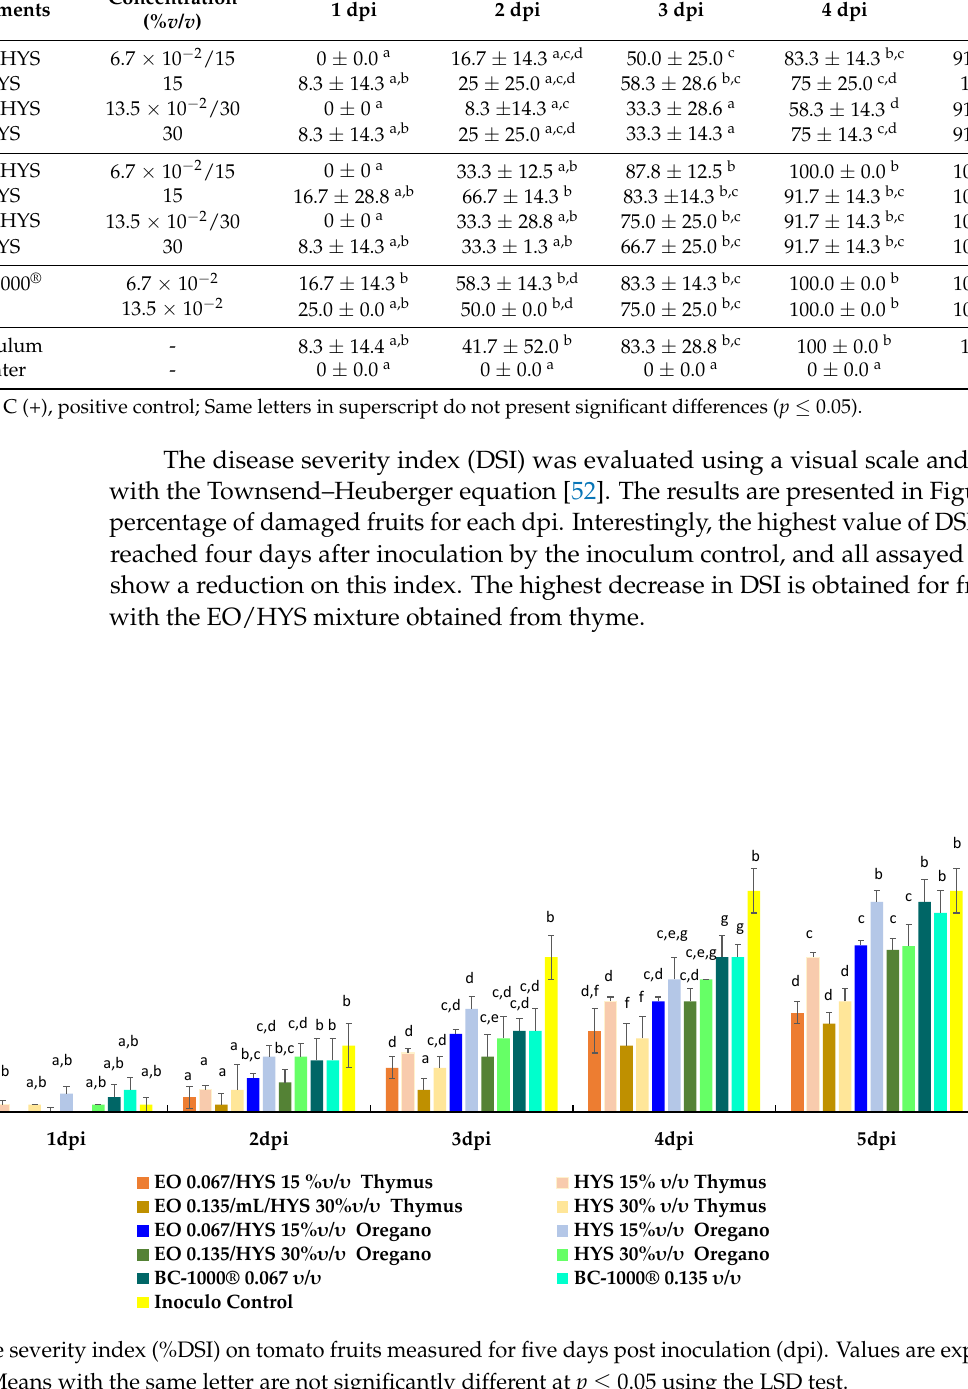
Figure 4. Disease severity index (%DSI) on tomato fruits measured for five days post inoculation (dpi). Values are expressed as mean ± SD. Means with the same letter are not significantly different at p ≤ 0.05 using the LSD test.